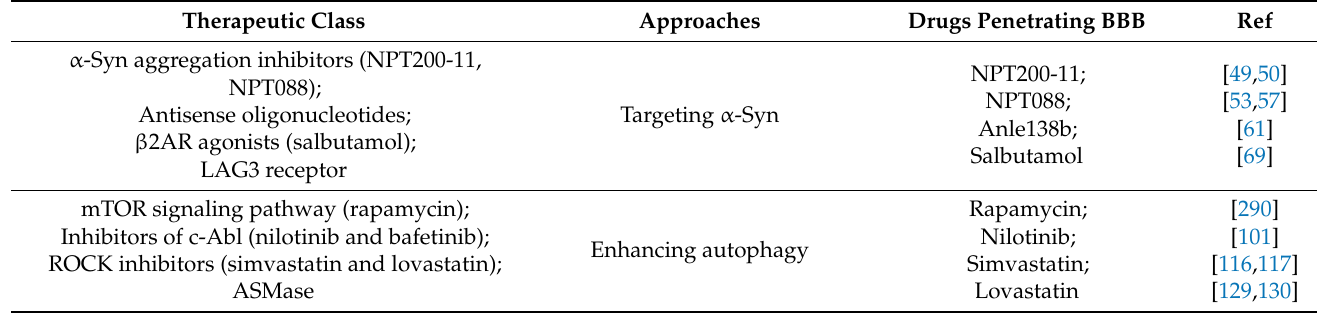
Table 4. Different approaches for PD